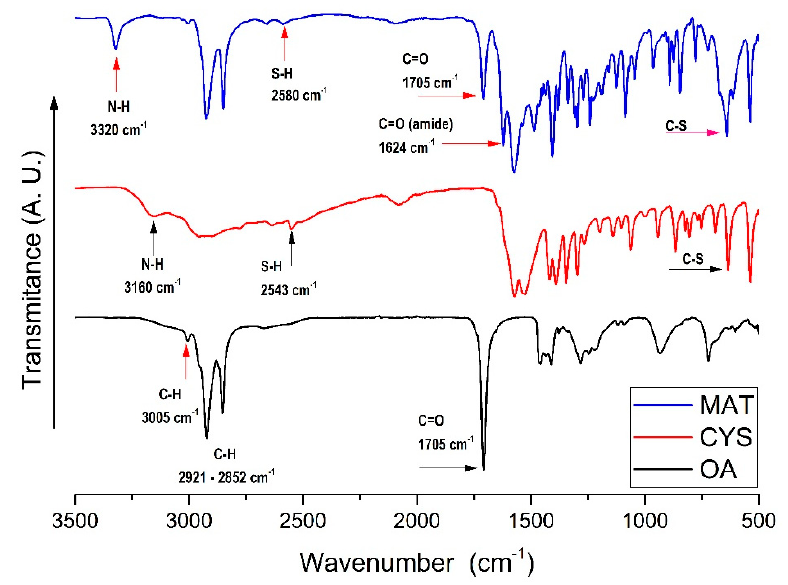
Figure 4. Infrared spectra; Oleic acid ( OA ), L-cysteine ( CYS ), and (C) Bioconjugate of oleic acid and L-cysteine ( MAT ).